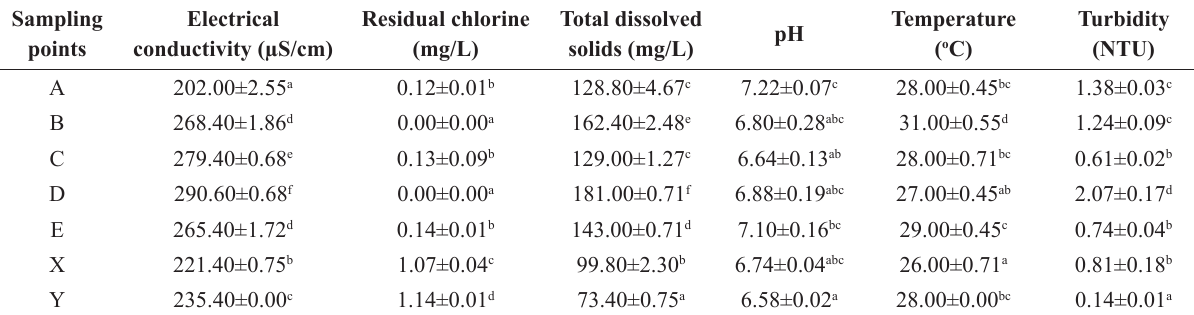
Table 1: Physicochemical properties of water samples taken at different sampling points